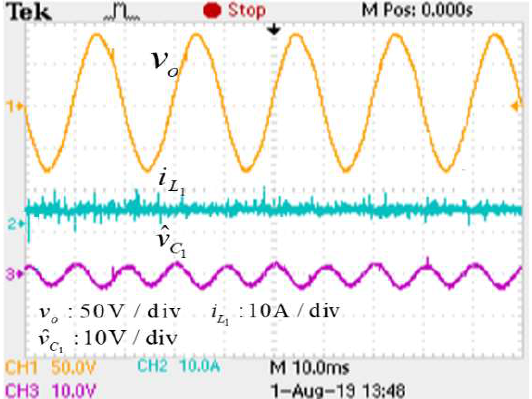
Figure 10. Experimental results with the RVCMS.